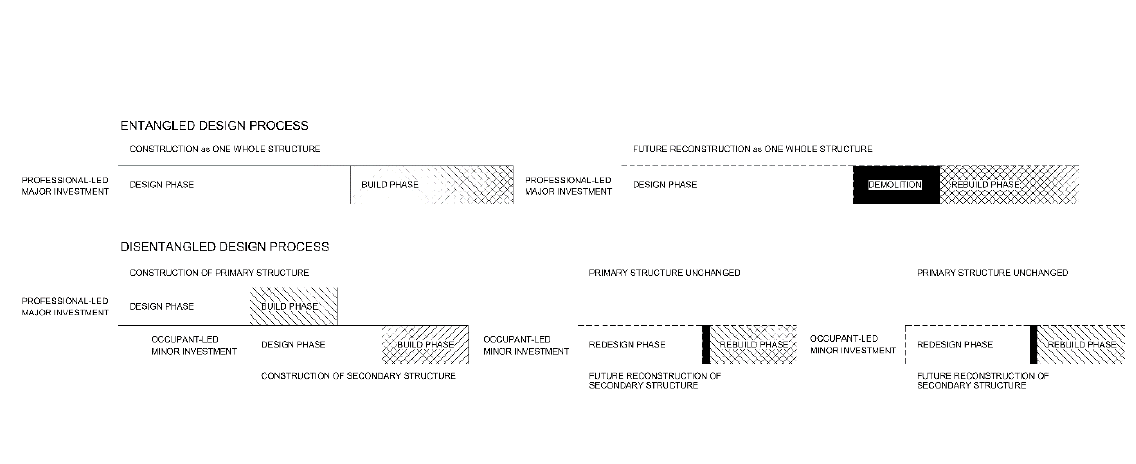
Figure 16: Comparison between entangled and disentangled design processes. By author,